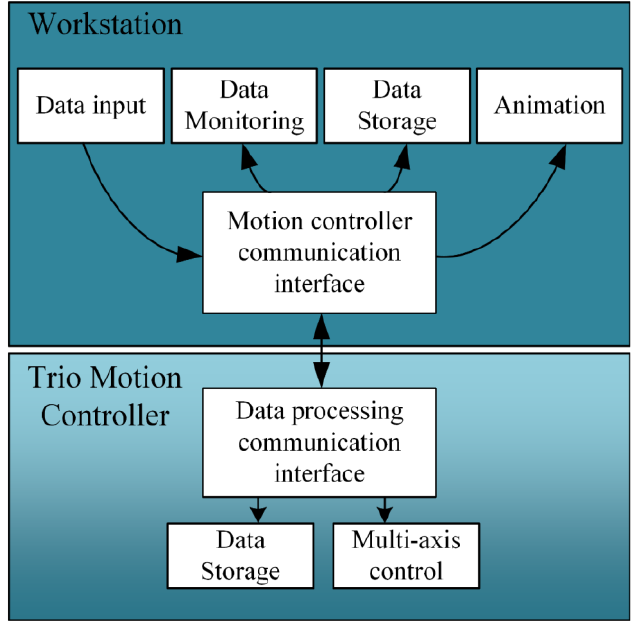
Figure 12. Software architecture.